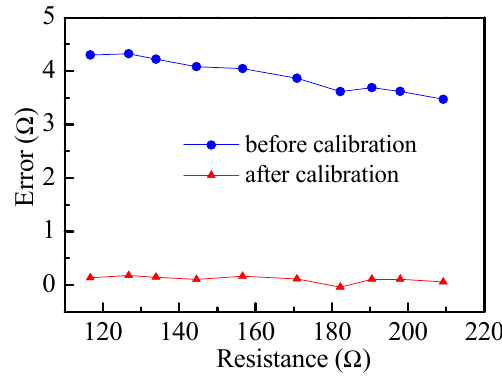
Figure 25. Effect of linear error calibration.